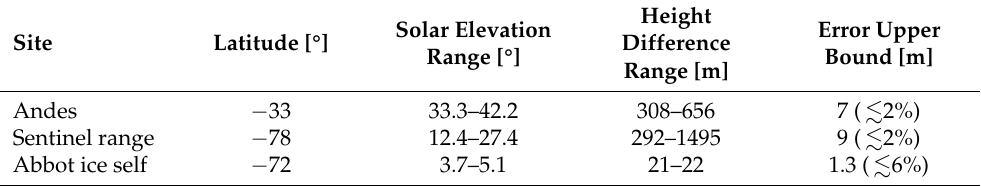
Table 5. Summary of upper estimates of errors observed at the three validation